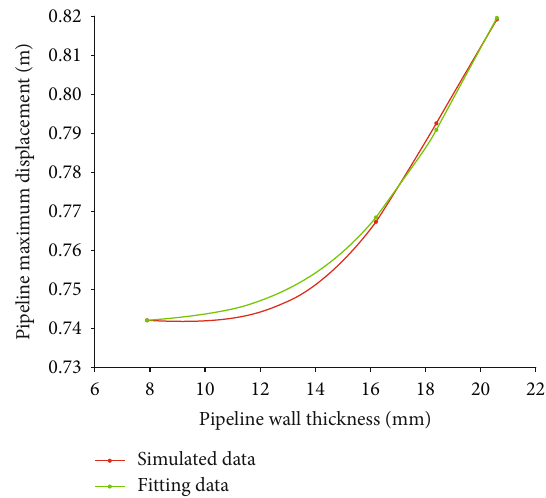
Figure 18: The pipeline maximum displacement under di ff erent pipeline wall thicknesses.